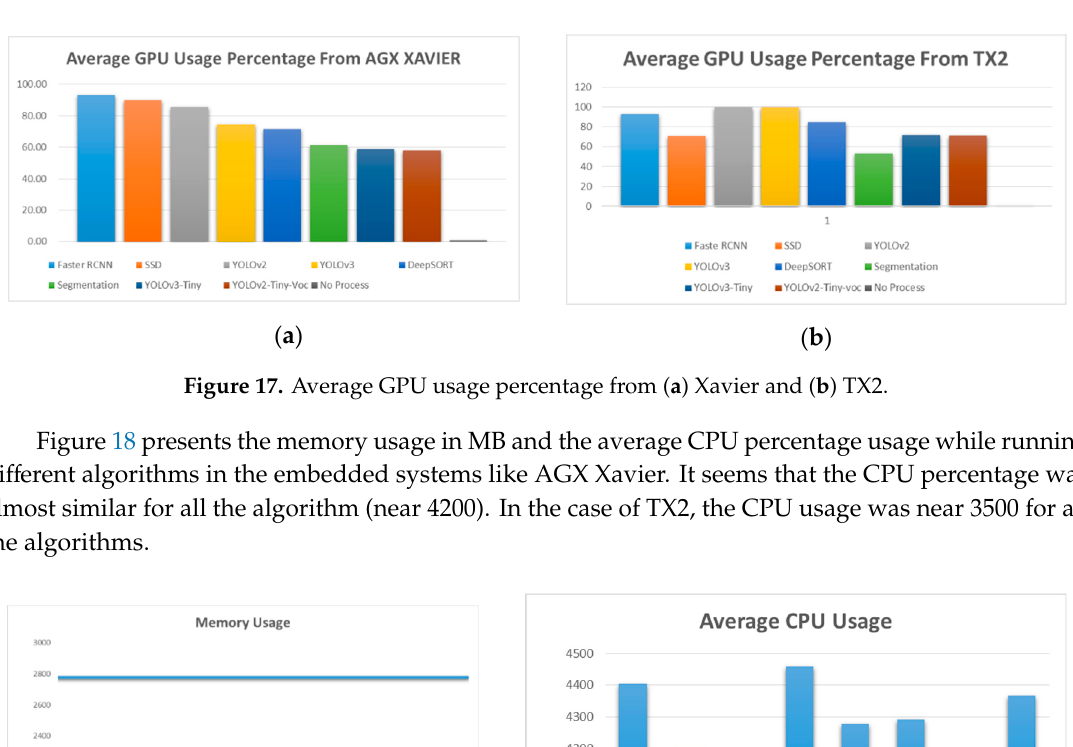
Figure 18. ( a ) Memory usage and ( b ) average CPU usage percentage in Xavier.